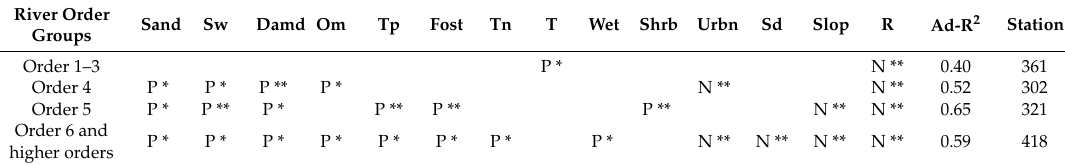
Table 3. Environmental controls on DOC concentrations by river